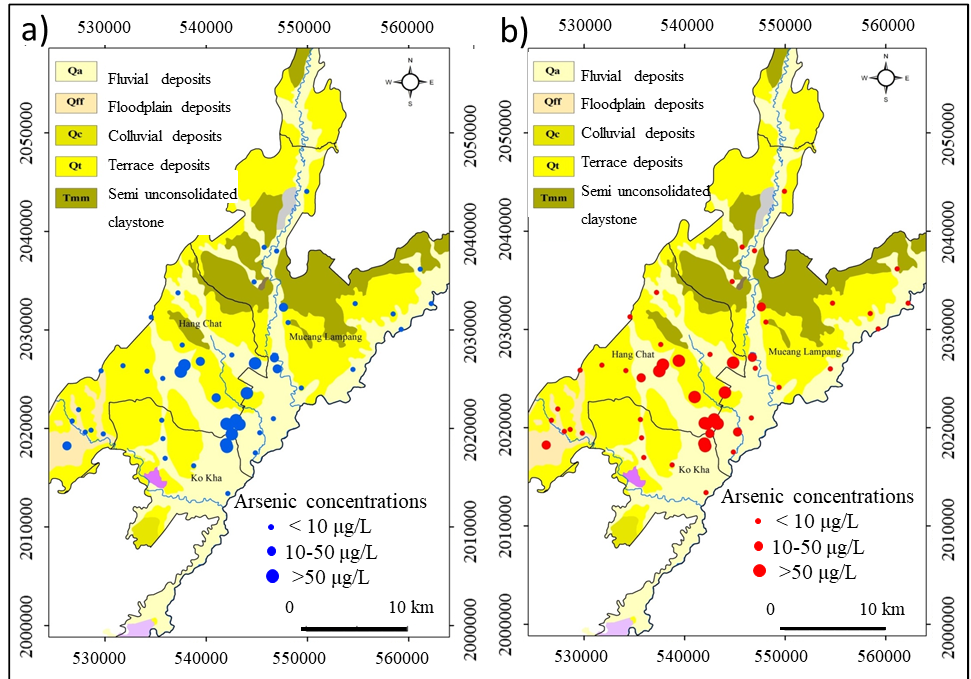
Figure 9. Arsenic content in deep wells for ( a ) wet season, and ( b ) dry season.